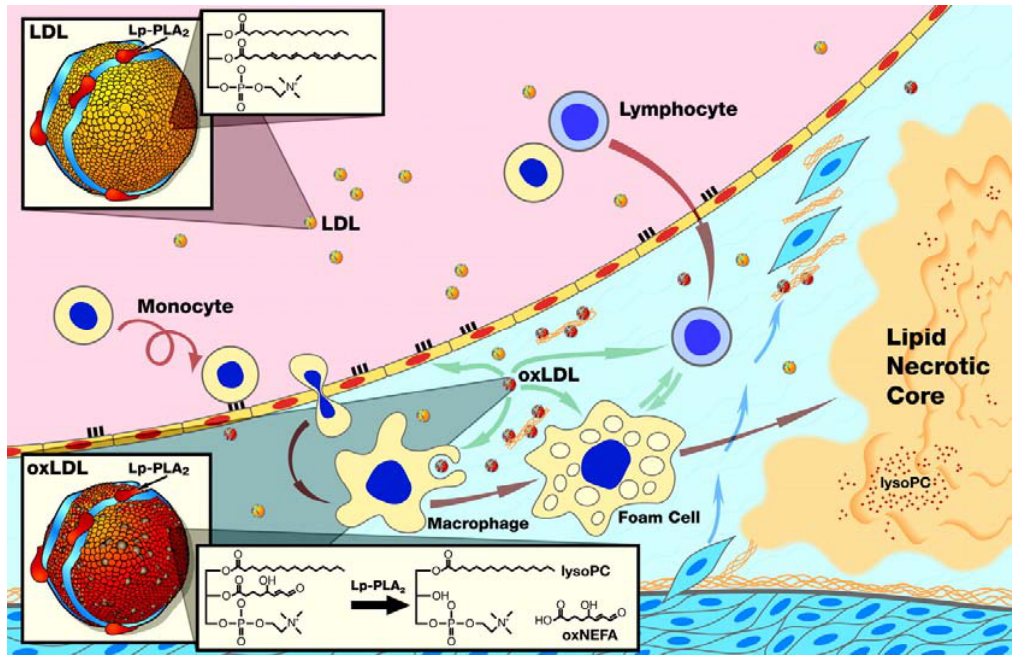
Figure 1. Schematic representation of the proposed pro-atherogenic mechanism of Lp- PLA in the vessel 2